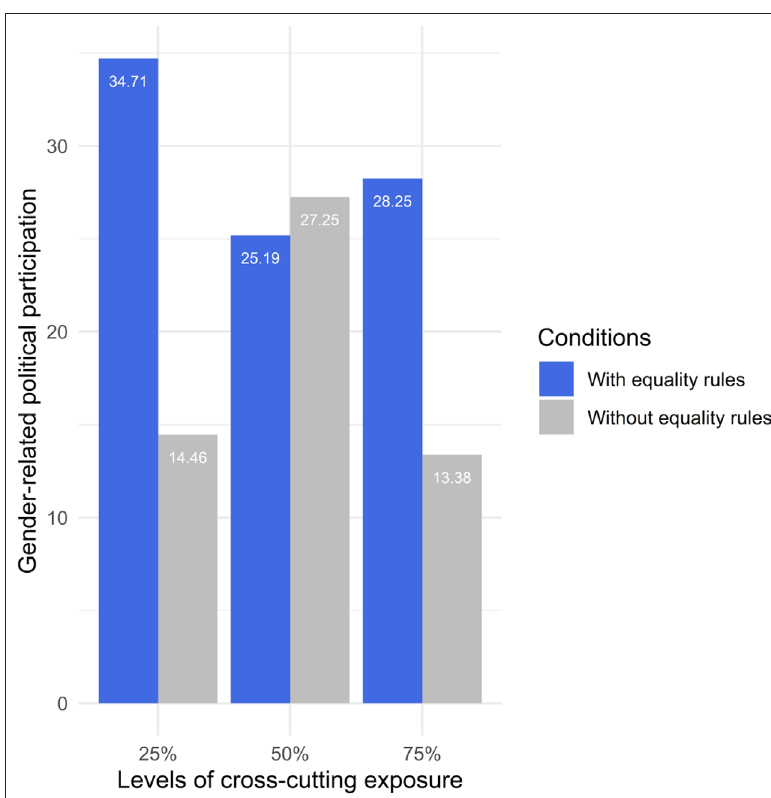
Figure 2: Gender-related political participation in different deliberative conditions. Note : Greater values indicate greater intention of participation on gender issues (7 items